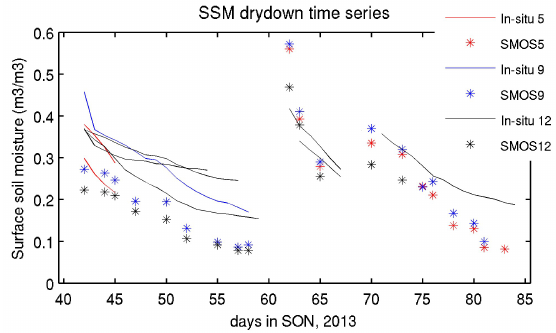
Figure 2. Surface soil moisture (SSM) dry-downs for In-situ (full line) and SMOS (*) data, during SON 2013. In-situ / SMOS 5, 9 and 12 refers to all in-situ /SMOS SSM dry-downs within Pixel5, Pixel9 and Pixel12 respectively.